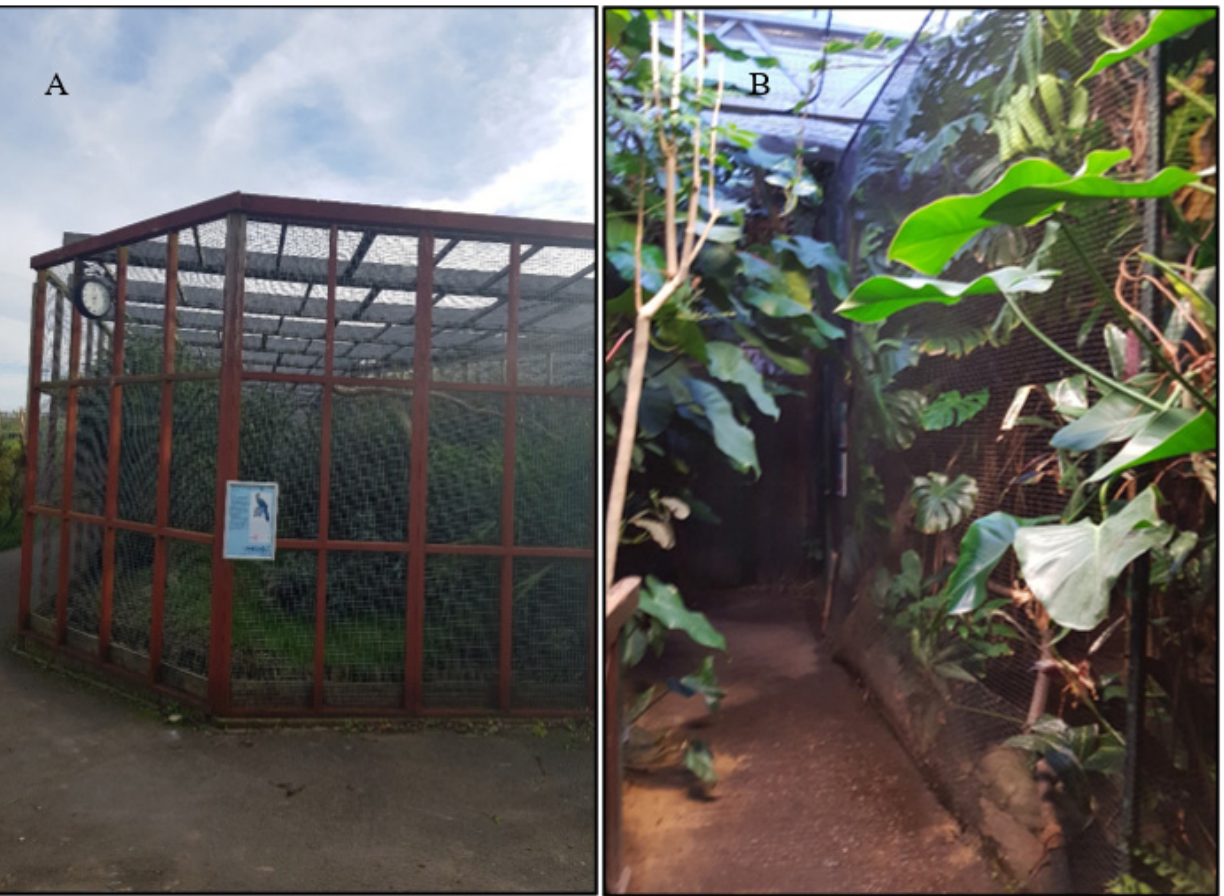
Figure 1. ( A ) One of the two White-cheeked Turaco aviaries at Sparsholt College and ( B ) Fischer’s Turaco enclosure at The Living Rainforest.